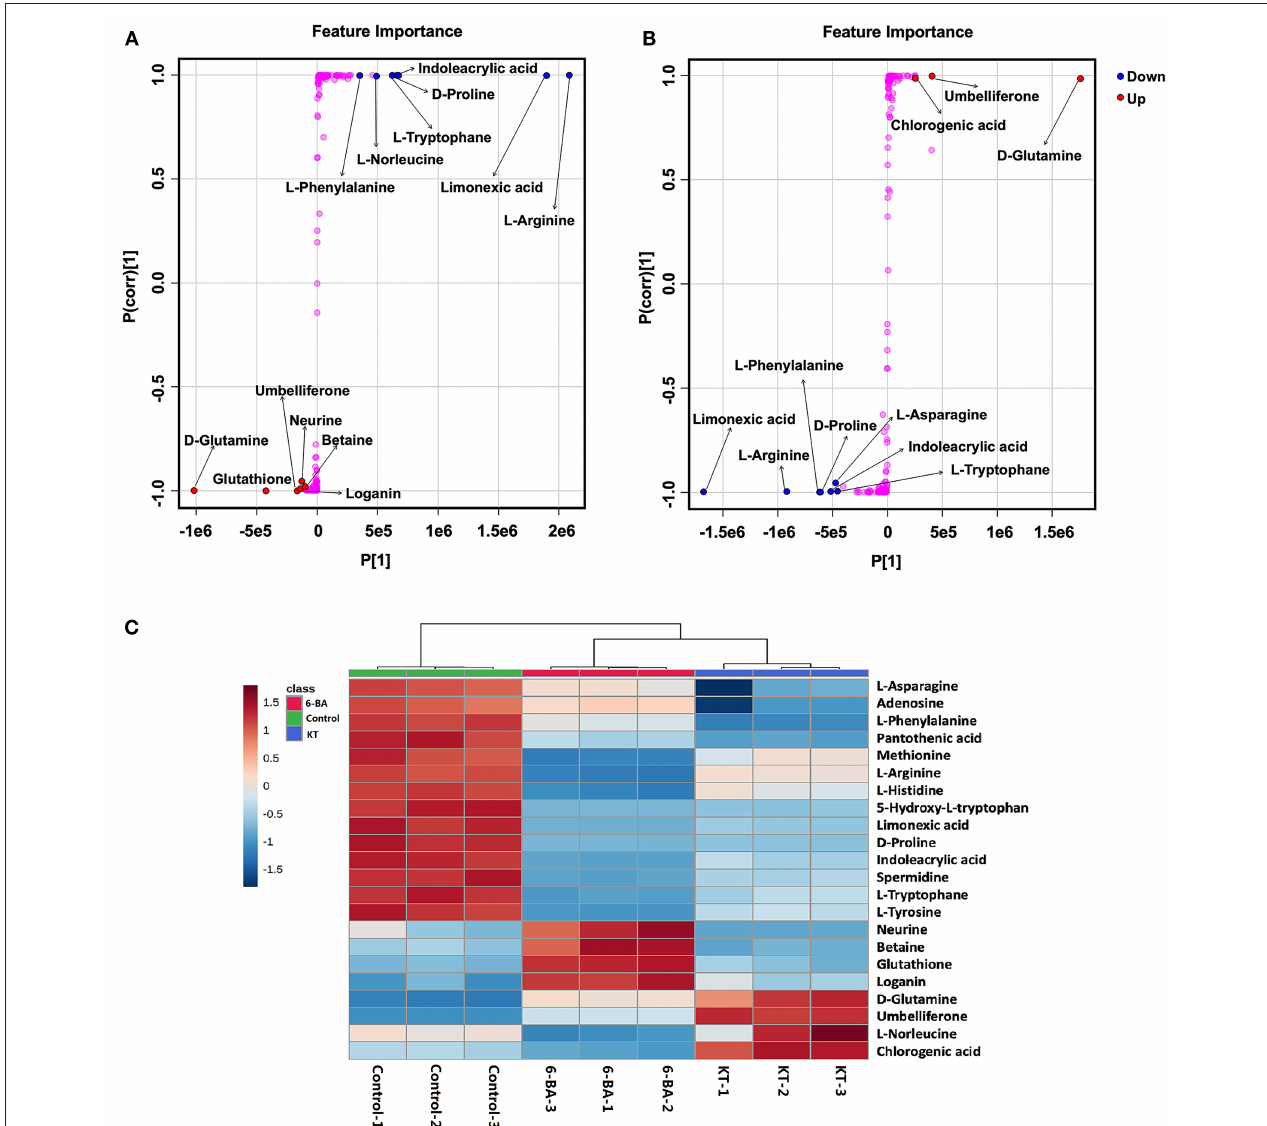
FIGURE 3 | The most important potential differential metabolites. (A) Potential differential metabolite identifications from S-plots in the 6-BA group. (B) Potential differential metabolite identifications from S-plots in the KT group. (C) Heatmap showing the intensities of significant metabolite expression features in PGRs compared with control